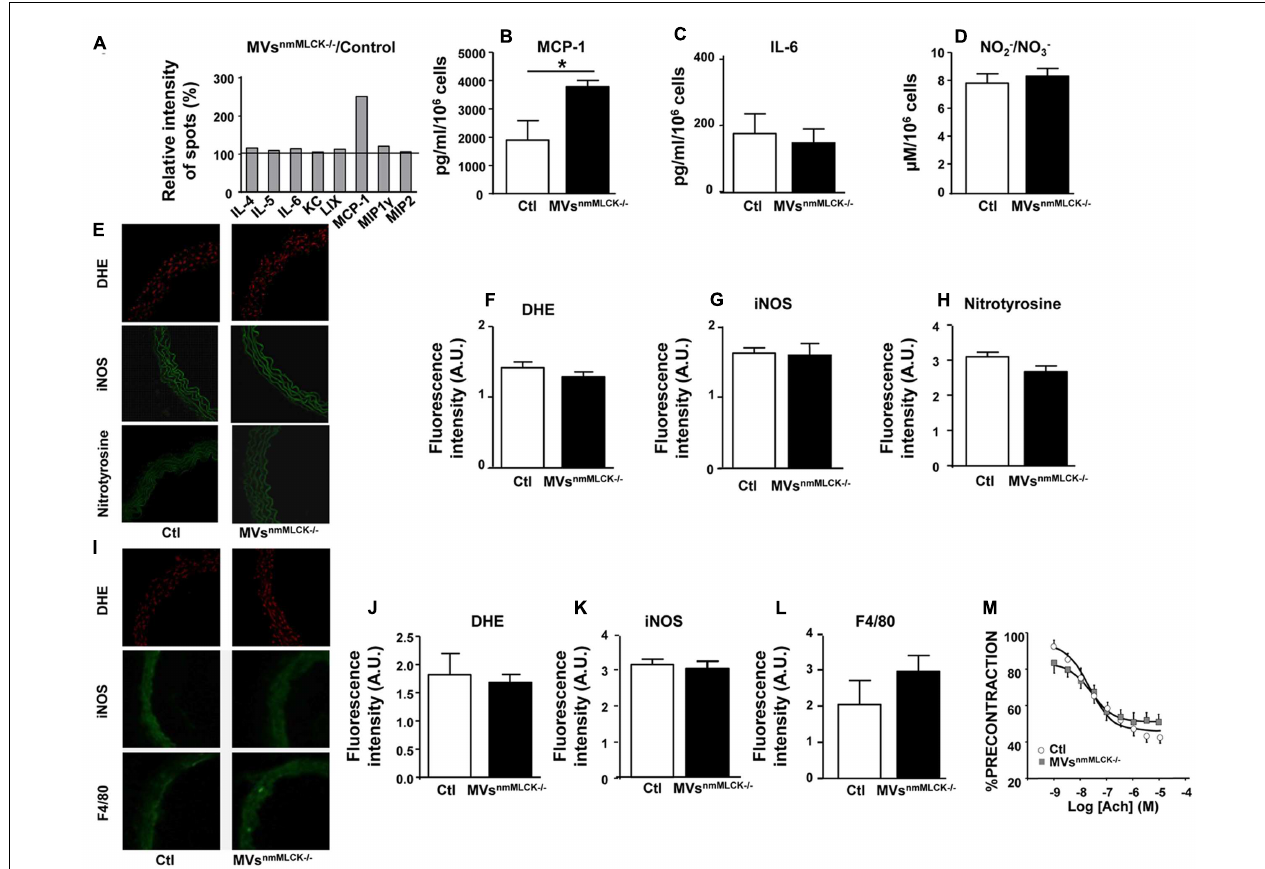
FIGURE 2 | Lack of effects of circulating MVs from non-muscular myosin light chain kinase (nmMLCK)-deficient mice. Primary endothelial cells isolated from mouse aorta (AoECs) of nmMLCK + / + mice were treated for 24 h with MVs nmMLCK − / − . Cytokine production was evaluated by Ray Bio Mouse Cytokine Antibody Array 3 kit (Supplementary Figure 1A). (A) Histograms show the cytokine ratio between either MVs nmMLCK − / − -treated versus non-treated cells (Control). Black line represents cytokine production of non-treated cells. Results are expressed as a percentage of relative intensity of spots (%). Data represent the mean of n = 3. Quantification of MCP1 (B) and IL-6 (C) secretion by ELISA assay. Data represent the mean of n = 3, ∗ P < 0.05. (D) Quantification of NO − 2 /NO − 3 (nitrite/nitrate) from the supernatant of AoECs previously treated by MVs nmMLCK − / − , using Griess assay. (E–H) Confocal image staining of superoxide anion production by DHE (red), iNOS (green), and nitrotyrosine expression (green) in mouse wild type aorta exposed 24 h ex vivo to either saline salt solution (Ctl) or MVs nmMLCK − / − . Aorta was imaged using confocal microscope. (F–H) Histograms show fluorescence intensity of aortic DHE staining (F) , iNOS (G) and nitrotyrosine (H) assessed by Image J. Background fluorescence intensity was subtracted using unstained aortas. Data are expressed in arbitrary units (A.U.) of fluorescence intensity and represent the mean ± SEM ( n = 3–5). (I–L) Confocal image staining of DHE (red), iNOS expression (green), and macrophage infiltration (F4/80 green) in aorta from wild type mice injected intravenously with saline salt solution (Ctl) or MVs nmMLCK − / − for 24 h. Histograms show fluorescence intensity of aortic DHE staining (J) , iNOS (K) and F4/80 (L) , assessed by Image J. Data expressed in A.U. of fluorescence intensity and represent the mean ± SEM ( n = 3–5). (M) Endothelium-dependent relaxation induced by acetylcholine (Ach) was evaluated by myography on aortic rings from wild type mice treated intravenously with MVs nmMLCK − / − at their circulating concentration. The relaxation was expressed as a percentage of precontraction level. Statistical analyses were performed using two-way ANOVA test. Data represent the mean of n =